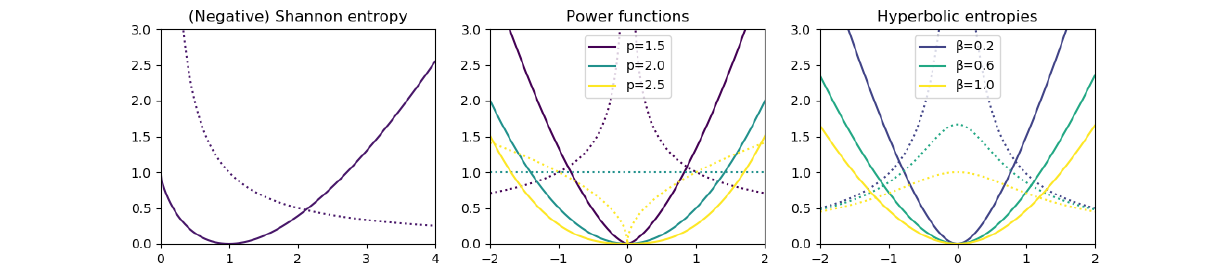
Figure 2 Divergence-generating functions (plain) and their second-order derivatives